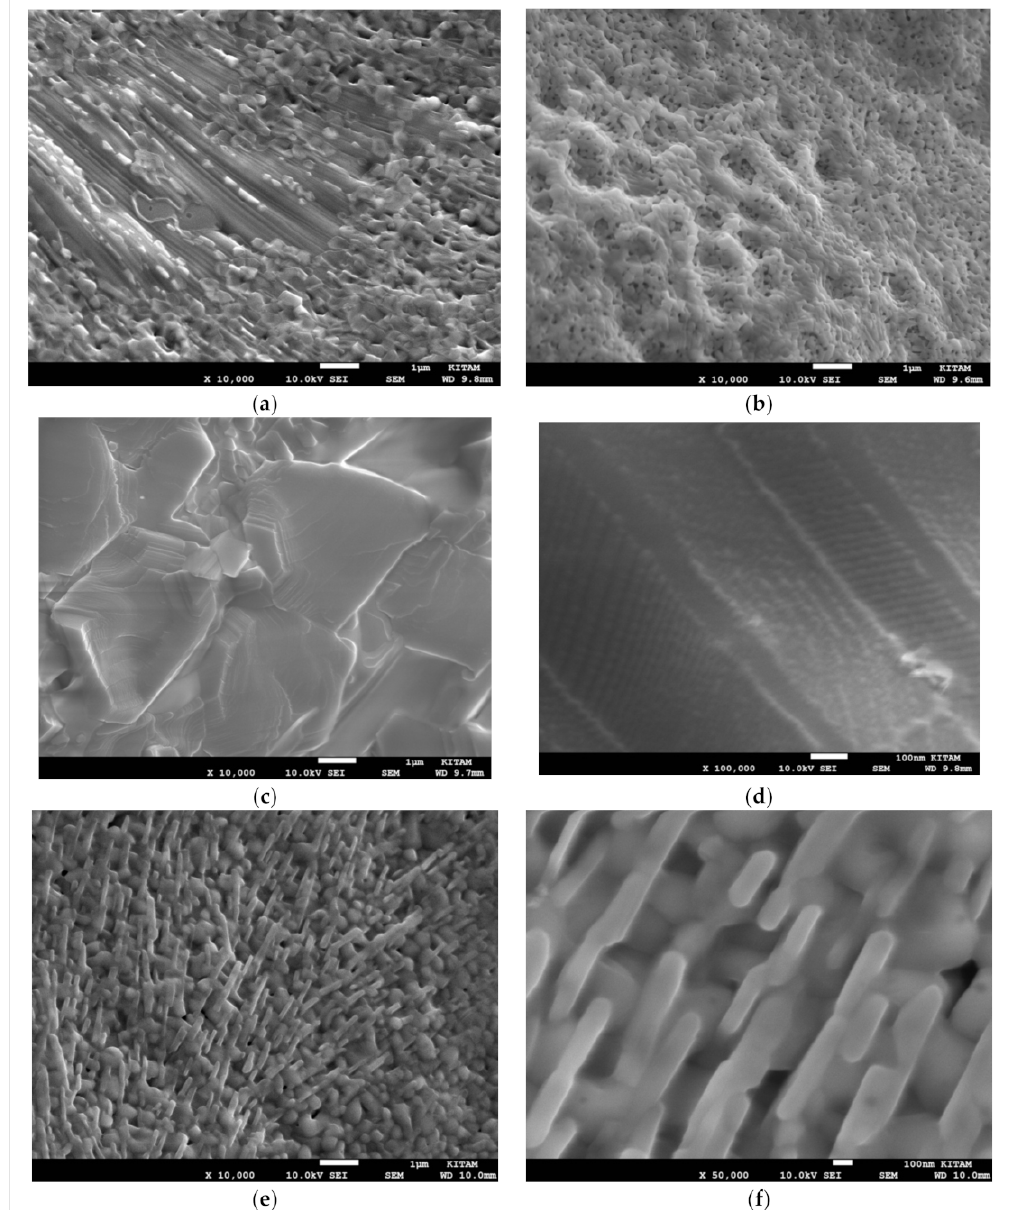
Figure 29. Structure of the Mn / Si = 2* catalyst surface and pore surface as a function of local chemical composition after an extra 60 s microwave irradiation with plasma generation of the fresh catalyst illustrated in Figure 28. ( a ) Surface structure at the average Mn but high SiO 2 level with composition: [Mn] = 0.365; [Si] = 0.075; [O] = 0.560; ( b ) Surface structure at the average Mn level and low silica with composition: [Mn] = 0.493; [Si] = 0.027; [O] = 0.480; ( c ) Surface structure at high Mn level with composition: [Mn] = 0.840; [Si] = 0.023; [O] = 0.137; ( d ) Surface structure at high Mn level shown in ( c ) but at higher magnification; ( e ) Pore surface structure at high Mn level with composition: [Mn] = 0.804; [Si] = 0.019; [O] = 0.177; ( f ) Pore surface structure shown in ( e ) at higher magnification. Scale bar = 1 µ m ( a – c , e ) and scale bar = 100 nm ( d , f